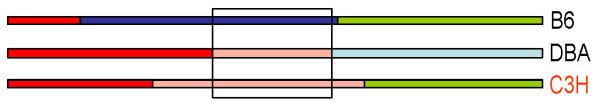
Determining nIBD-BXH regions from IBD blocks between mouse strains. B6 refers to C57BL/6J, DBA refers to DBA/2J, and C3H refers to C3H/HeJ. Horizontal bars represent genomic sequence. Regions that are in the same color between two or more strains represent the IBD blocks between those strains. nIBD-BXH (indicated with a box) are regions that are IBD between C3H/HeJ and DBA/2J, but nIBD between C3H/HeJ and C57BL/6J, and nIBD between C57BL/6J and DBA/2J, as explained in the text.